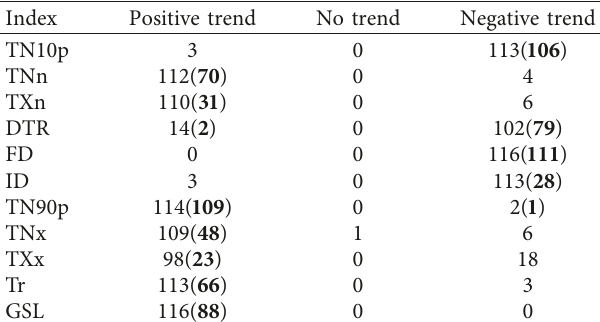
Table 2: Number of meteorological stations with positive (sig- nificant at 95% confidence level), no, and negative (significant at the 95% confidence level) trends for the temperature indices during